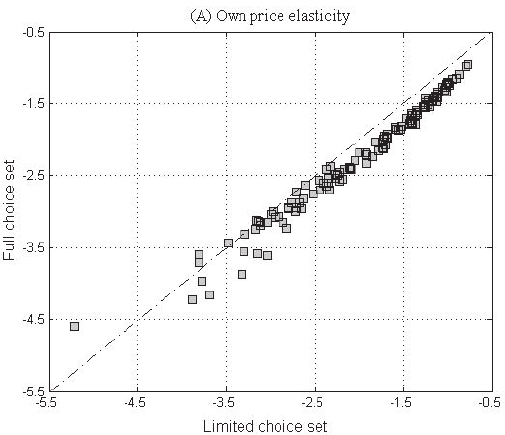
<Figure 4> Scatter plots of price elasticities estimated from consideration set (X-axis) and full consideration set (Y-axis) models Panel (A) shows own elasticities while panel (B) shows cross-price